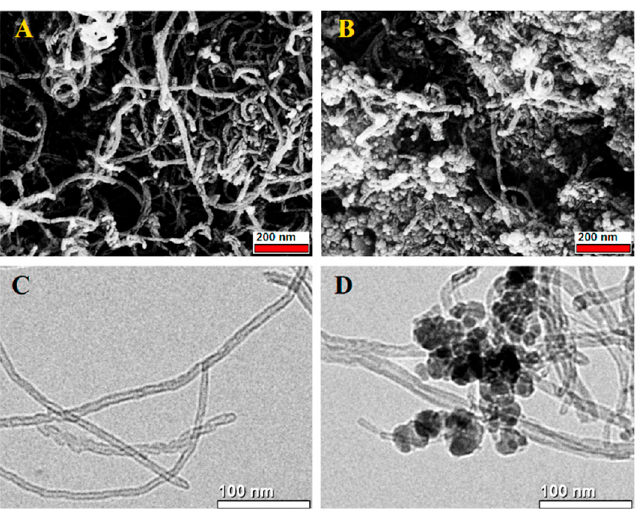
Figure 16. SEM ( A , B ) and TEM ( C , D ) images of MWCNTs and MWCNTs/CuFe 2 O 4 nanocomposite [133].